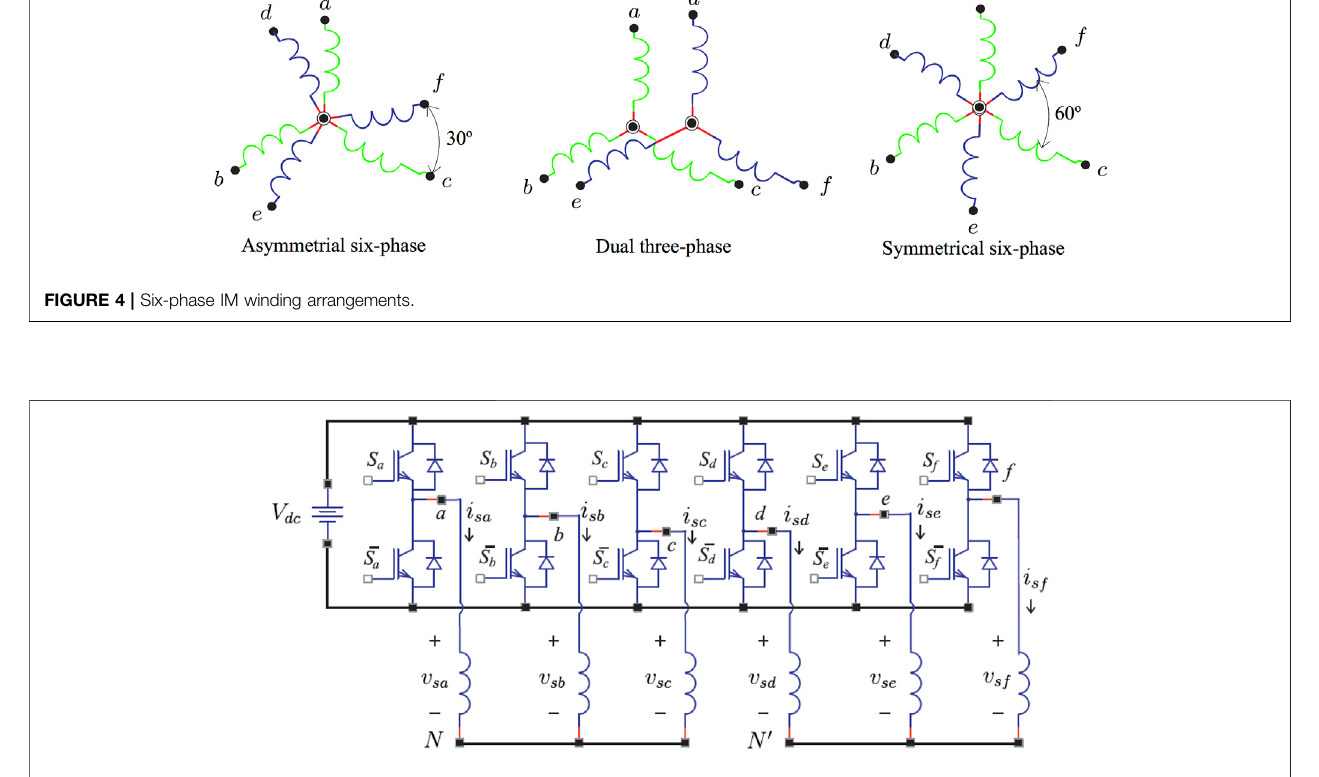
FIGURE 5 | Schematic diagram of the six-phase, two-level